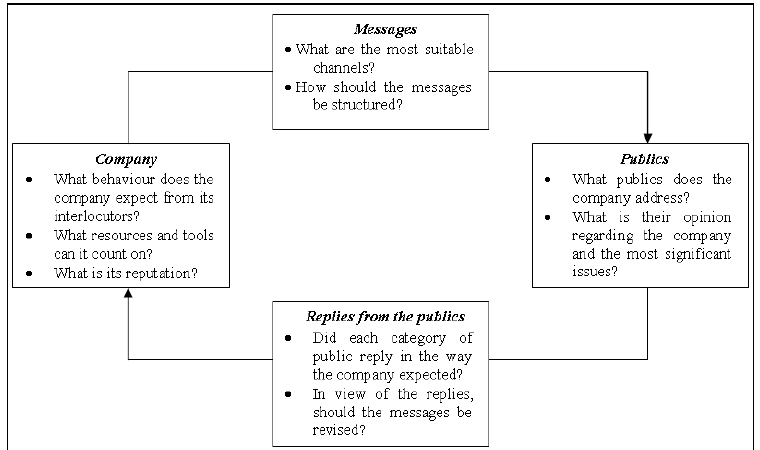
Figure 2: Development of the Corporate Communication